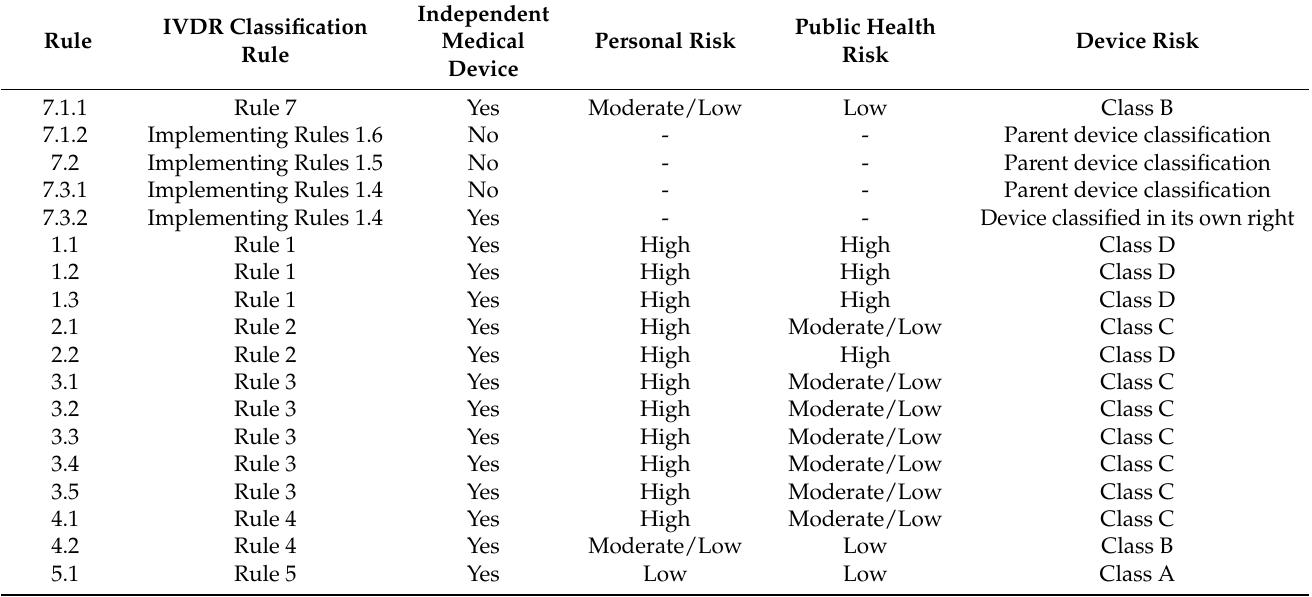
Table 2. IVDR Classification Rules dataset for the IVDR decision